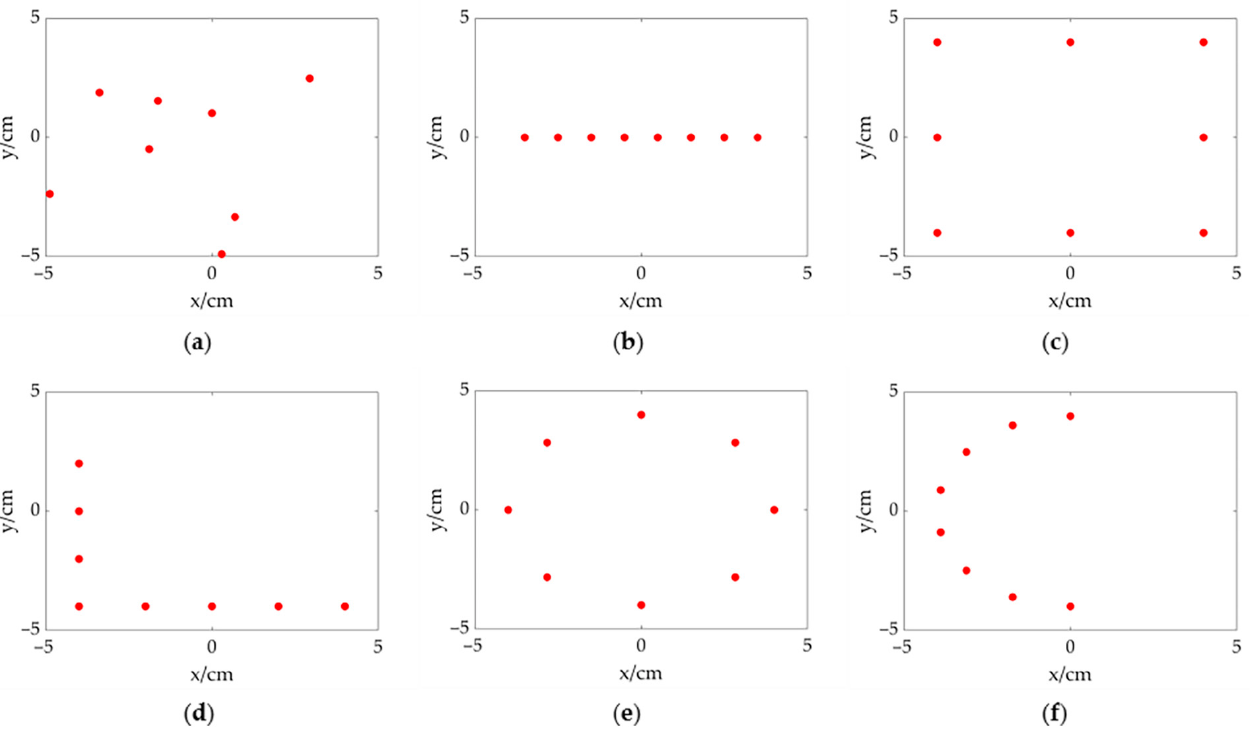
Figure 2. Array topologies (the red dots represent sensors). ( a ) proposed random topology; ( b ) line topology; ( c ) rectangular topology; ( d ) L-shaped topology; ( e ) circular topology; ( f ) semi-circular topology.